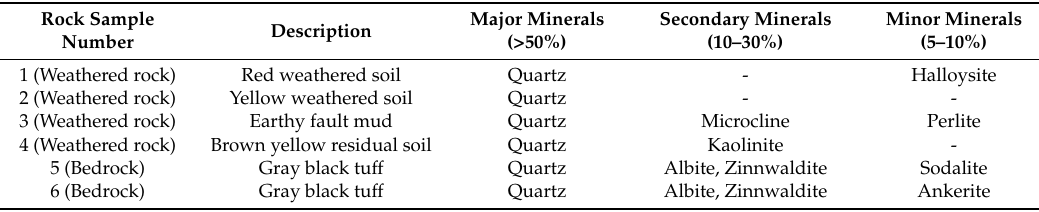
Table 2. The results of XRD for mineral